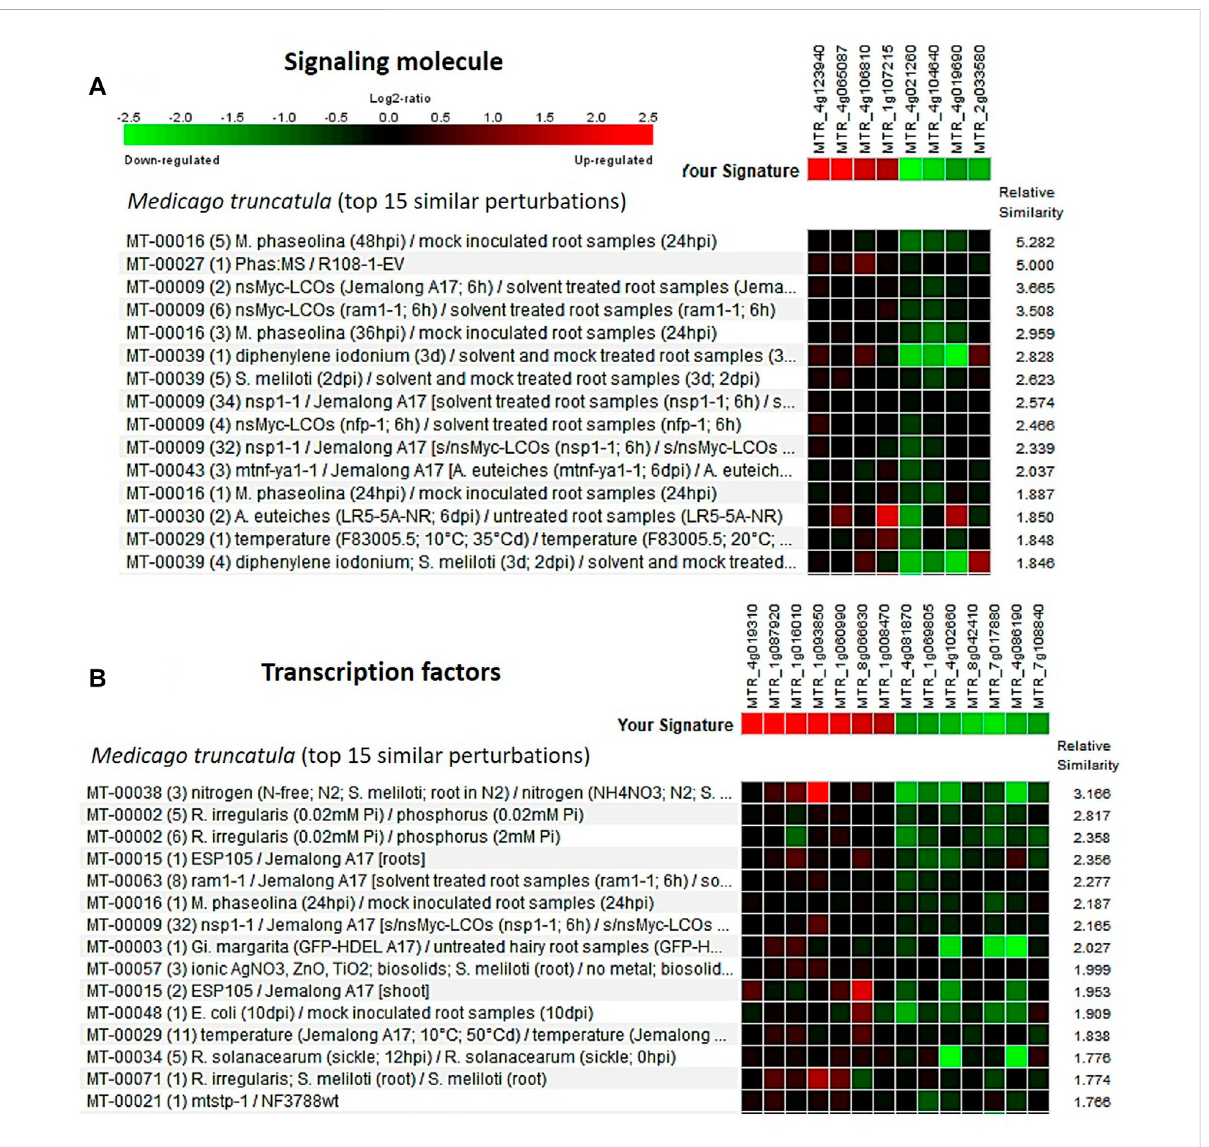
FIGURE 6 Heat map generated using the DEGs associated with (A) signaling molecule and (B) transcription factors from the lentil genotypes (early seed developmental stage). Genevestigator ® was used, and the top 15 perturbations are